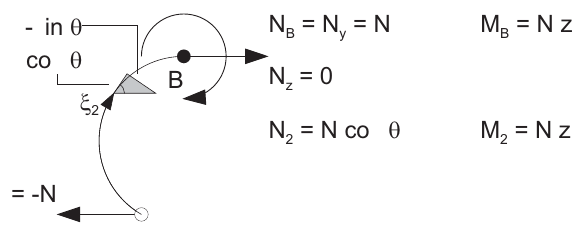
Figure 5: Equilibrium at unit cell and internal line loads